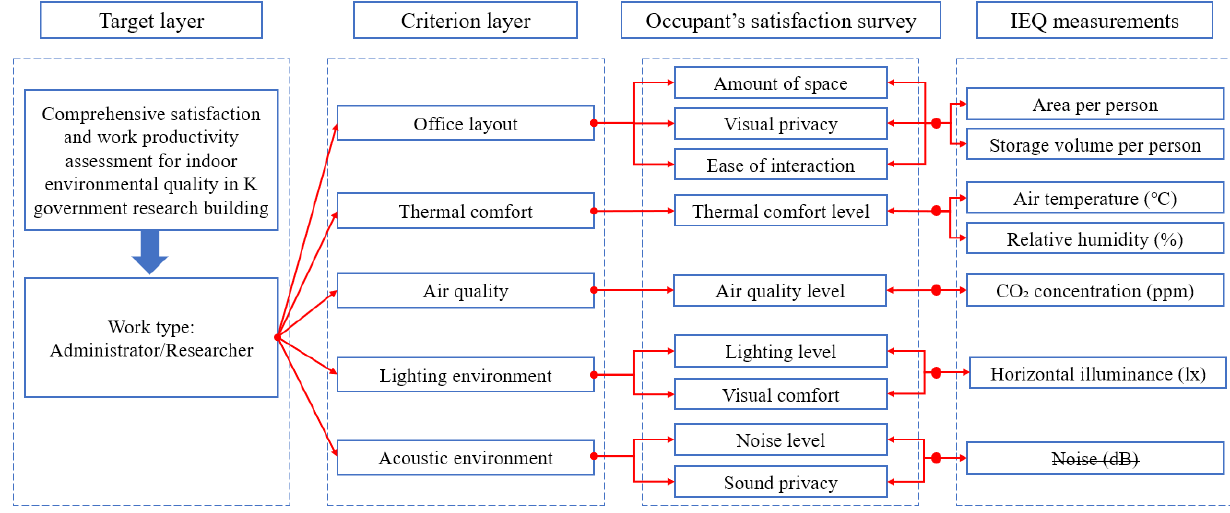
Figure 1. Framework used for analysis in the present study. Table 1. Basic information on the administrator and researcher